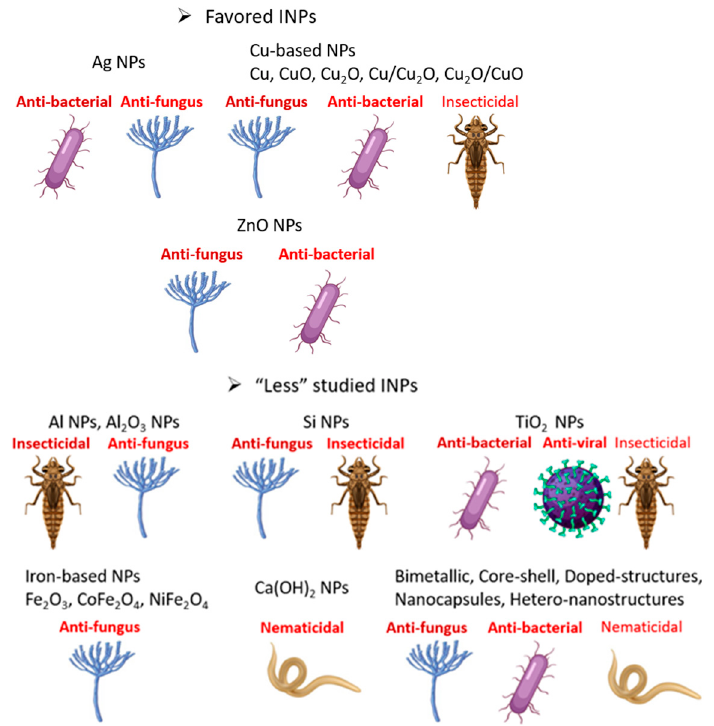
Figure 4. Schematic presentation of the favored INPs and the “less” studied INPs used as anti-phy- topathogenic agents and tested in vitro, in pot experiments, and under greenhouse conditions.